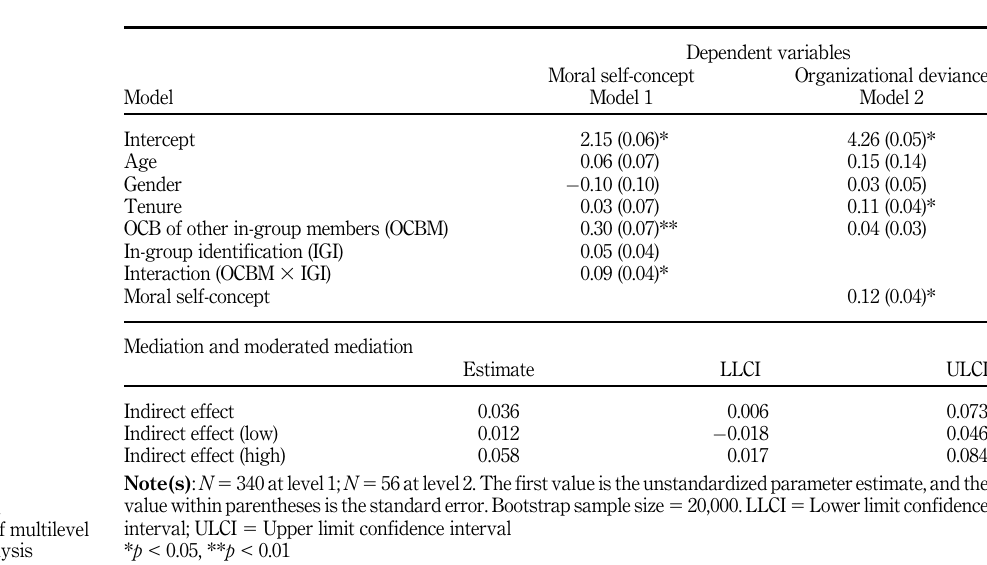
Table 1. Descriptive statistics, correlations, and reliabilities